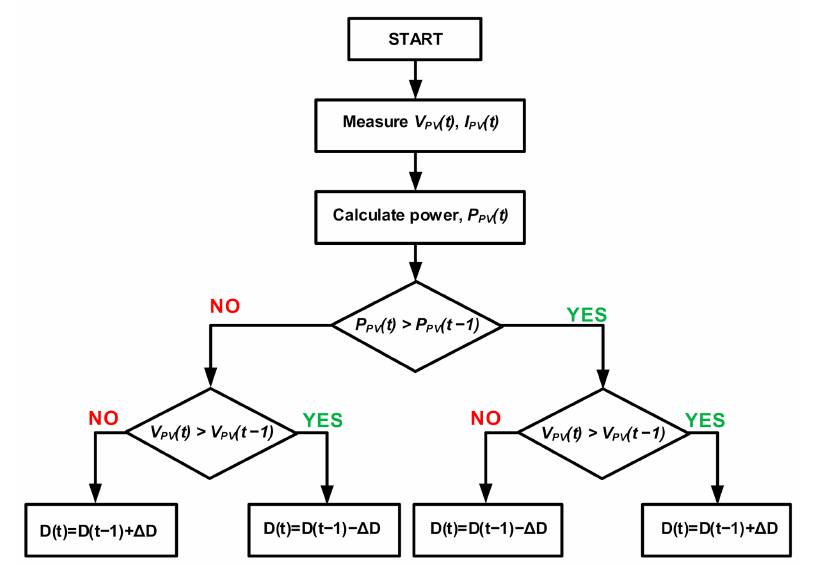
Figure 9. Flow chart of Perturb and Observe method